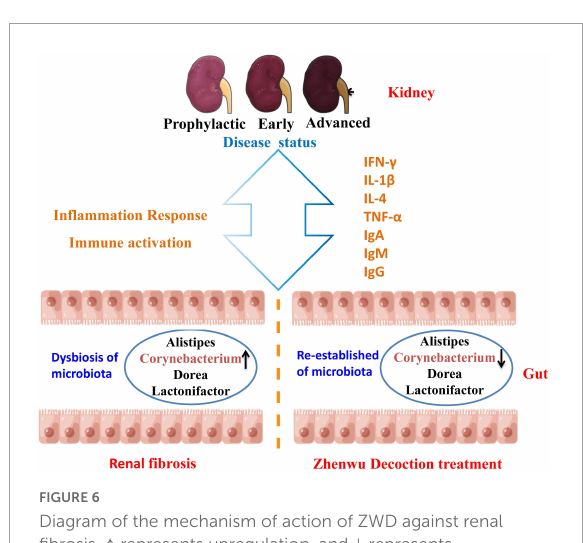
FIGURE6 Diagram of the mechanism of action of ZWD against renal fibrosis. ↑ represents upregulation, and ↓ represents